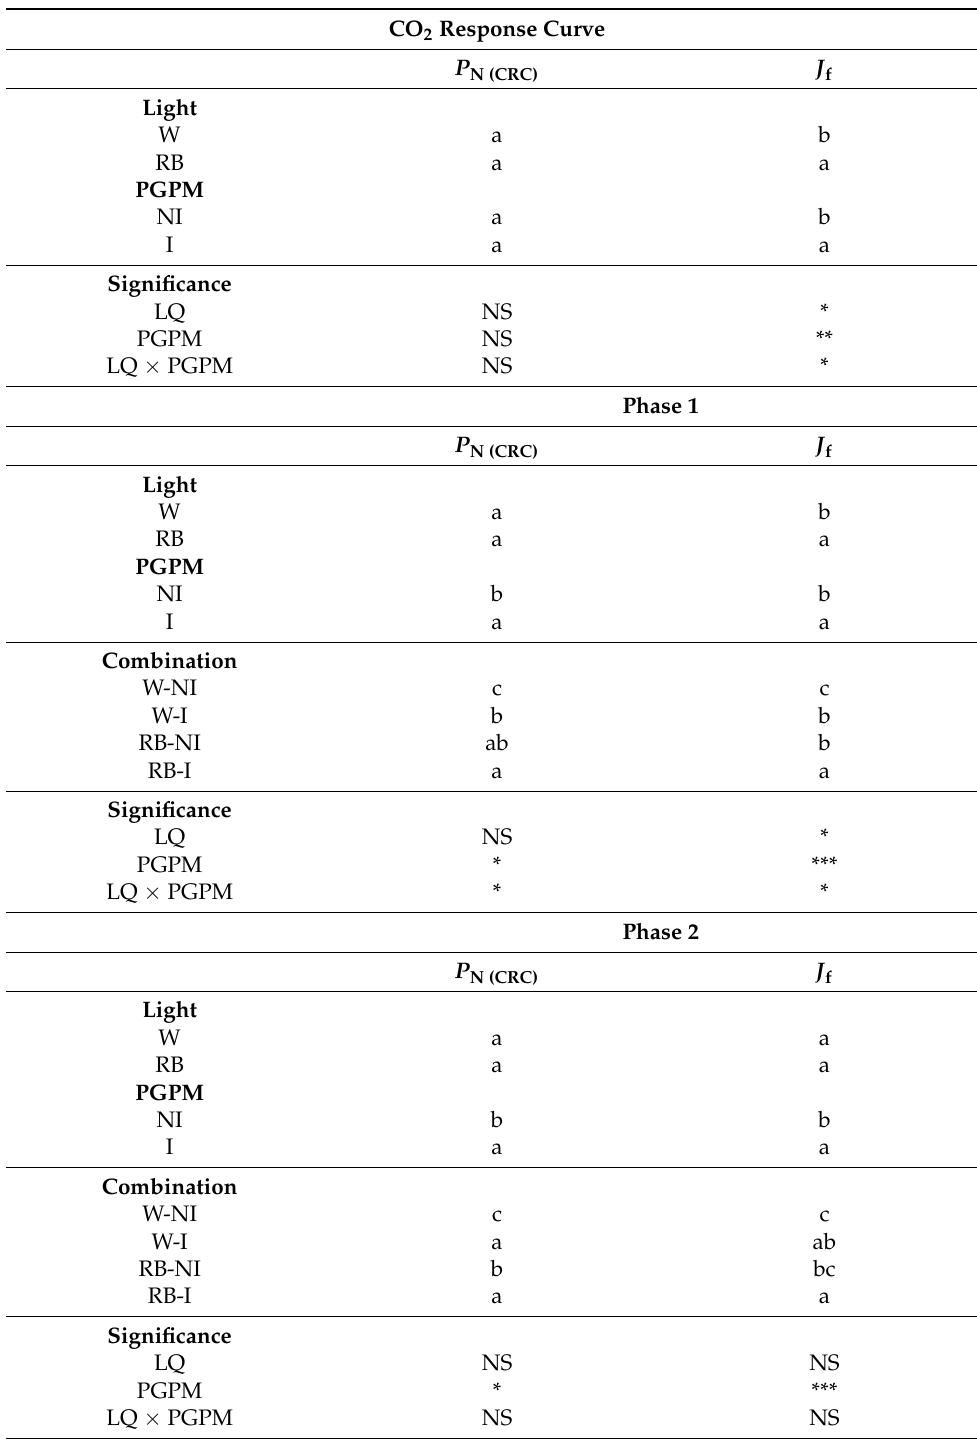
Table 3. Analysis of variance and comparison of means for the CO 2 response curve (CRCs)-derived photosynthetic functional traits P N (CRC) and J f in response to light quality (LQ), plant-growth promoting microbes (PGPM), and their interaction (LQ × PGPM). Different letters in each column indicate significant differences according to Student–Newman–Keuls (SNK) test ( p ≤ 0.05).